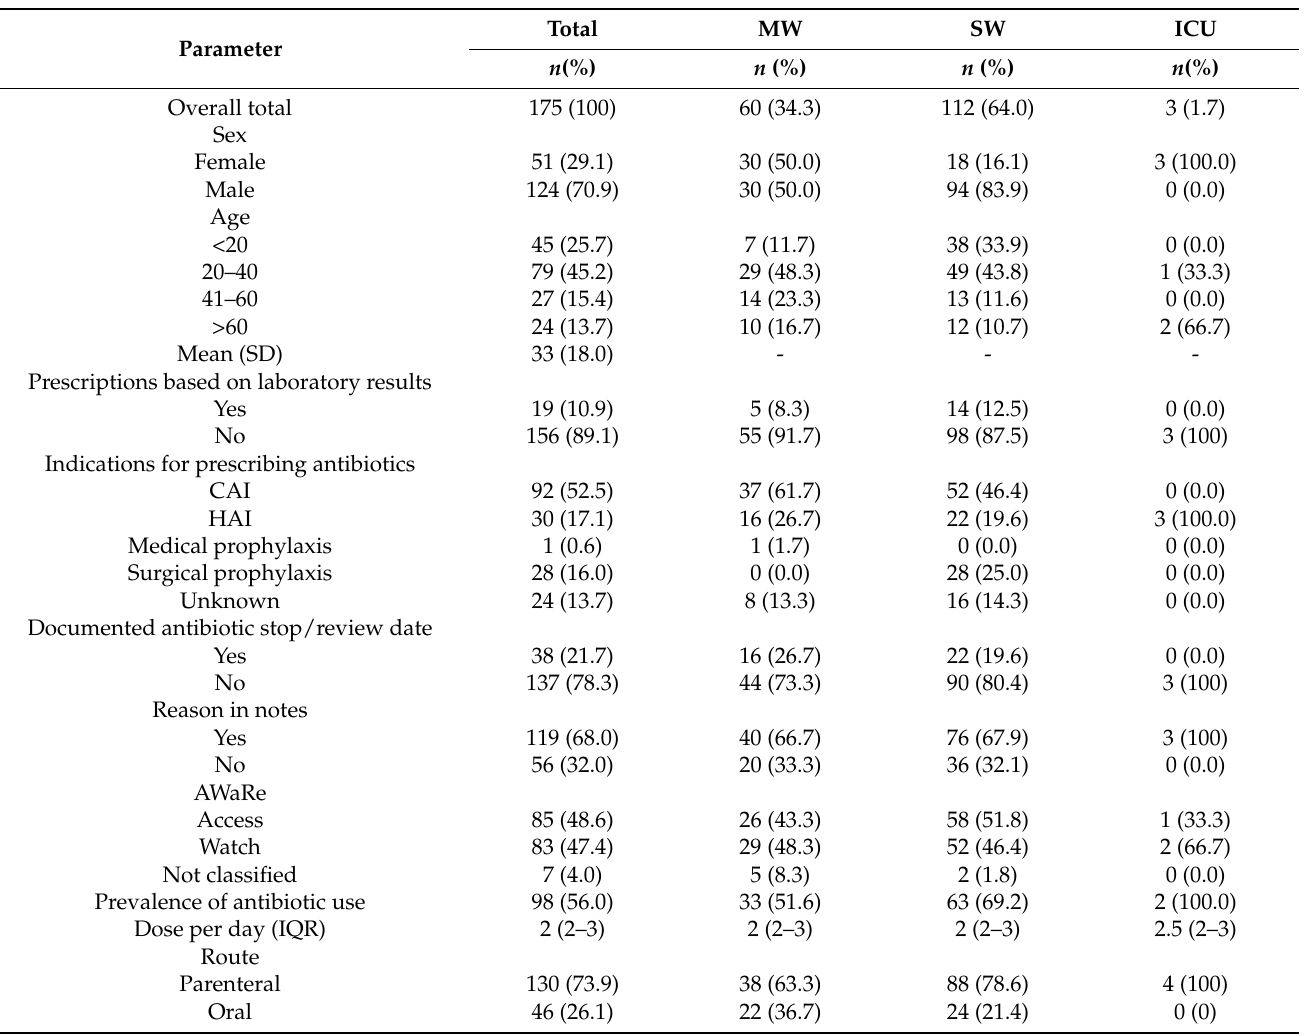
Table 1. Demographic characteristics of participants and antibiotics prescribing patterns.